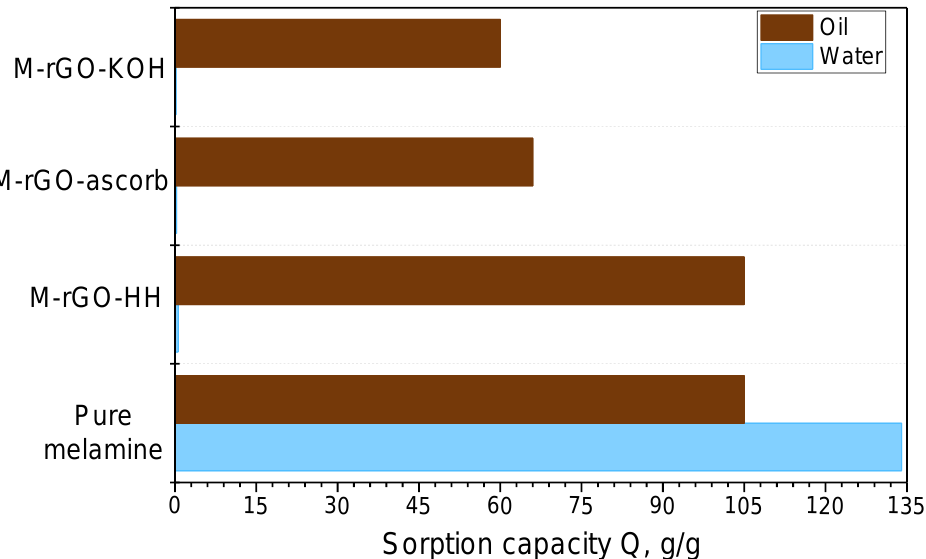
Figure 6. Sorption of water and oil by melamine – rGO composites compared to an untreated melamine matrix.